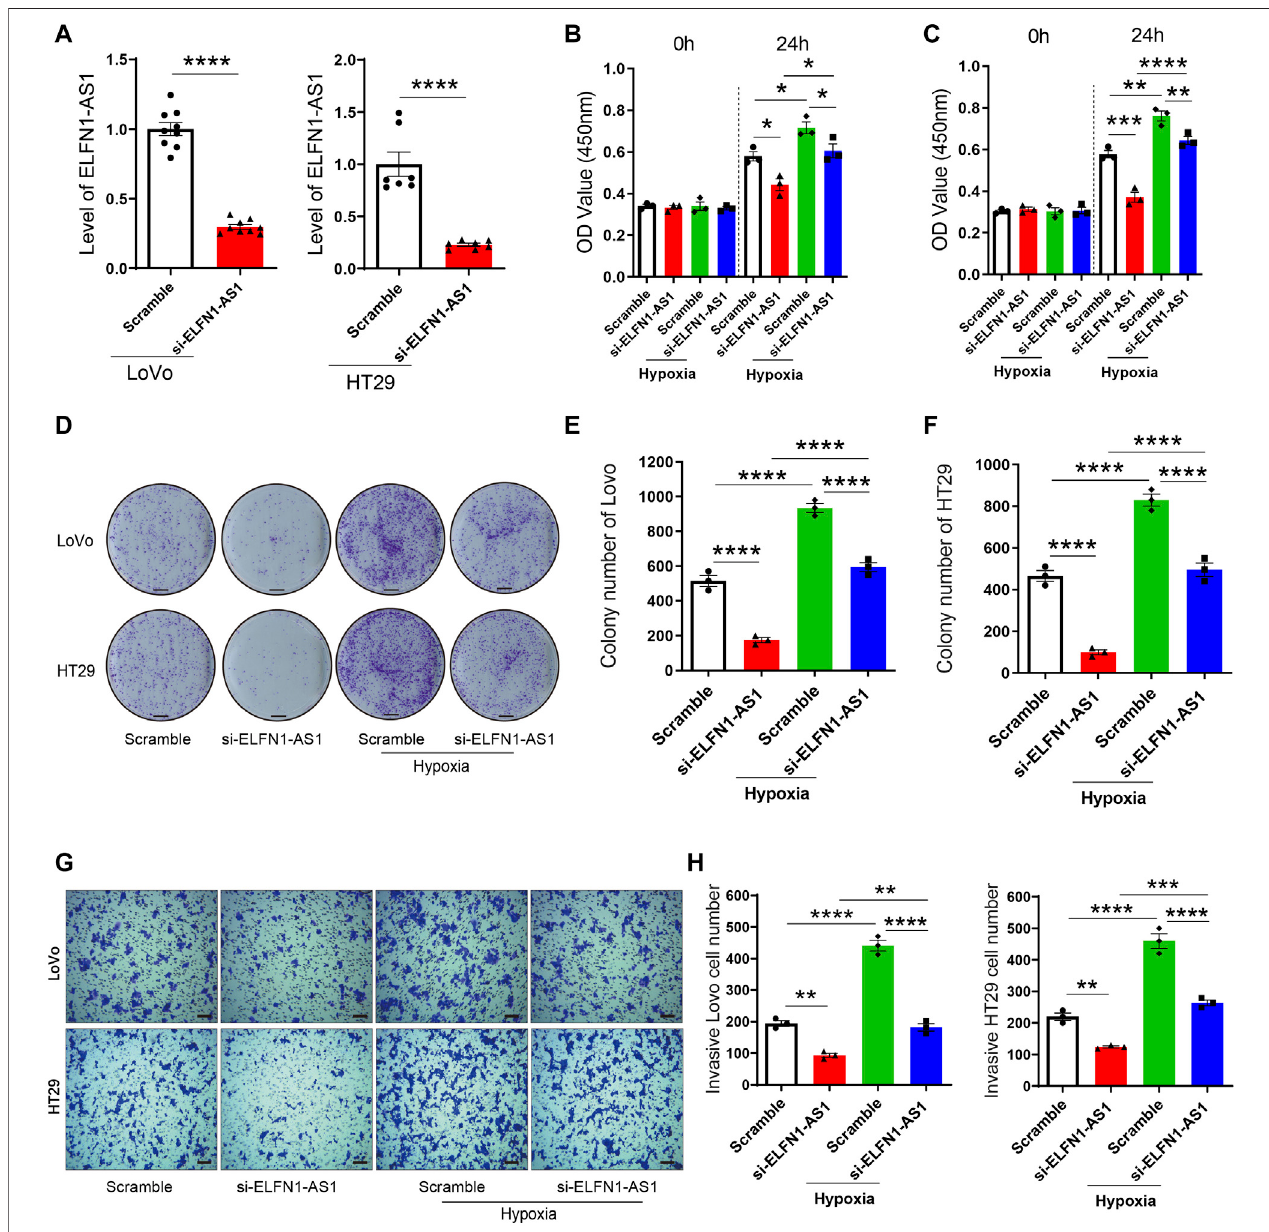
FIGURE 2 | ELFN1-AS1 rescues the proliferation and invasion induced by hypoxia in colon cancer cells. (A) ELFN1-AS1-speci fi c siRNAs were transfected into LoVo and HT29 cells with the negative siRNA as a control (Scramble). The ELFN1-AS1 level was detected using qRT-PCR after the transfection for 24 h. A t -test was used for this comparison. (B) and (C) After transfection with ELFN1-AS1 siRNA and empty plasmids, LoVo and HT29 cells were cultured in 5% CO 2 and 95% N 2 to generate the hypoxia + scramble and hypoxia + siELFN1-AS1 groups. Cell viability was detected using CCK8 assay. (D) Proliferation of LoVo and HT29 cells was determined using acolony formation assay. The photo ofthe plates was taken after 14 days ofincubation. (E) and (F) Colony number of each group was counted in fi ve random fi elds. Scale bar 5 mm. (G) Transwell assay was performed to detect the invasion of each group. After 24 h of culture in matrigel chambers, cells were photographedunderamicroscopeat×100magni fi cation.Scalebar100 µ . (H) Numberofinvasivecellswascountedinthreerandom fi elds.One-wayANOVAwasused forthecomparison betweenthemultiplegroupswithBonferroniasaposthoctest. Alldatawererepresentative ofthreeindependentexperiments.* p < 0.05;** p < 0.01; *** p < 0.001; **** p <